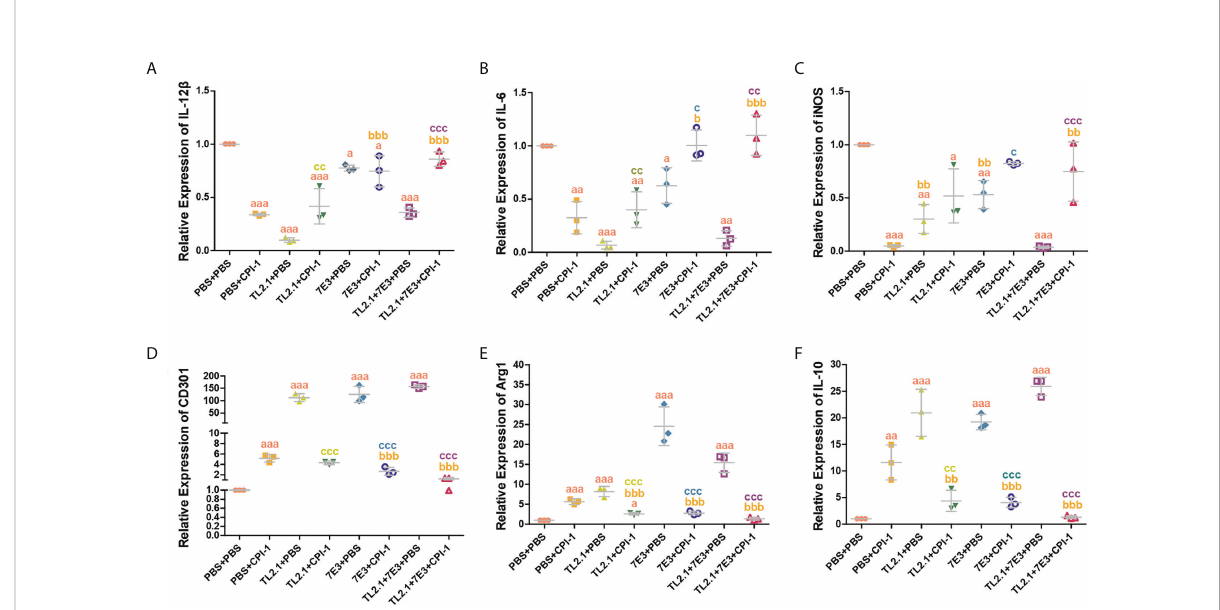
FIGURE 6 Blocking experiments were performed to analyze TLR2/4 directly affecting the polarization of MDMs. qPCR analysis of the transcript levels of M1 macrophage surface marker molecules (A – C) and M2 macrophage surface marker molecules (D – F) . The data are shown as the mean ± SD of 3 repetitions per group. a P ≤ 0.05, aa P ≤ 0.01, and aaa P ≤ 0.001 vs. the control group (PBS + PBS); b P ≤ 0.05, bb P ≤ 0.01, and bbb P ≤ 0.001 for the TL2.1+ rBsCPI-1, 7E3 + rBsCPI-1, or TL2.1 + 7E3 + rBsCPI-1 group vs. the PBS + rBsCPI-1 group; c P ≤ 0.05, cc P ≤ 0.01, and ccc P ≤ 0.001 for the TL2.1 + rBsCPI-1 group vs. the TL2.1 + PBS group, the 7E3 + rBsCPI-1 group vs. the 7E3 + PBS group, or the TL2.1 + 7E3 + rBsCPI-1 group vs. the TL2.1 + 7E3 + PBS